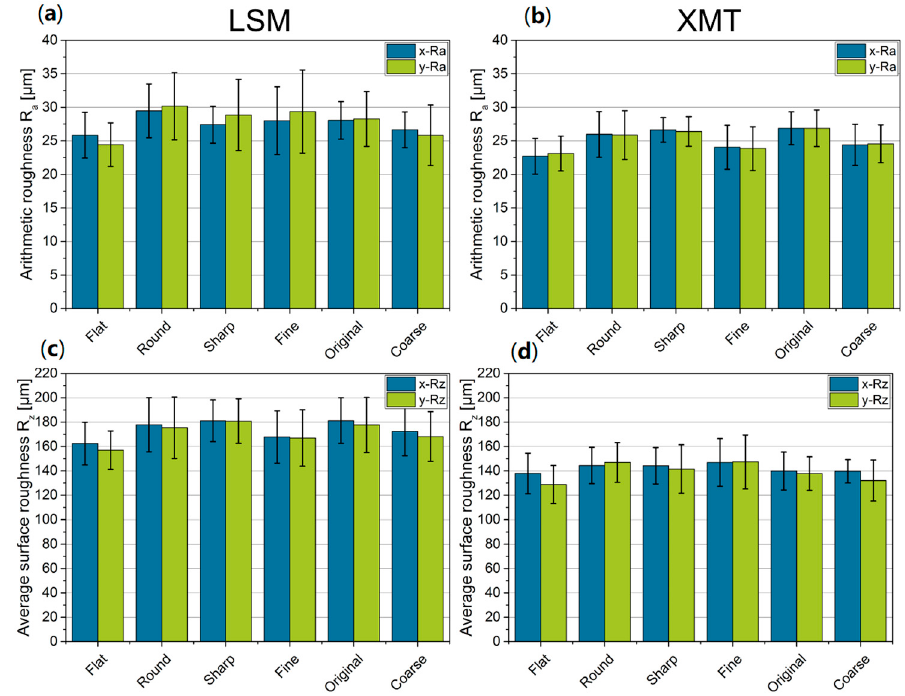
Figure 11. Mean arithmetic and average surface roughness of powders in deposition and orthogonal direction depending on blade geometry determined by LSM ( a,c ) and micro XMT ( b,d ).